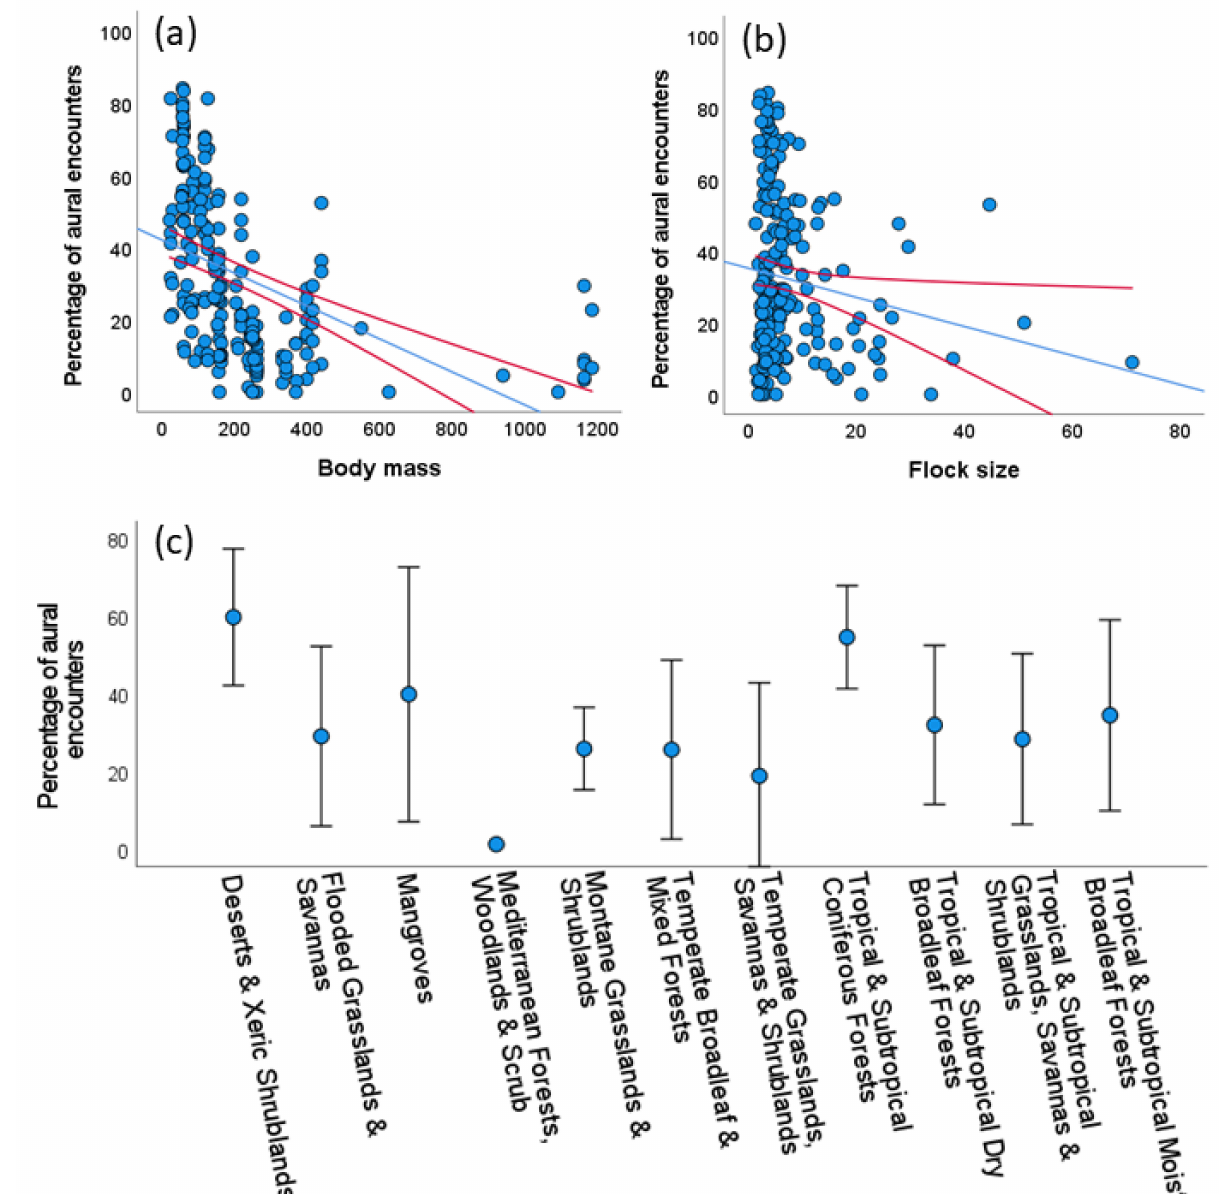
Figure 2. Univariate relationships between the percentage of aural encounters (i.e., when parrots were only heard), and ( a ) their body mass (in g), ( b ) their average flock size (number of individuals/number of visual encounters), and ( c ) the biomes surveyed in 191 study cases with at least 15 encounters per parrot species. Red lines (in a , b ) and bars (in c ) show 95% confidence intervals. See Results for multivariate